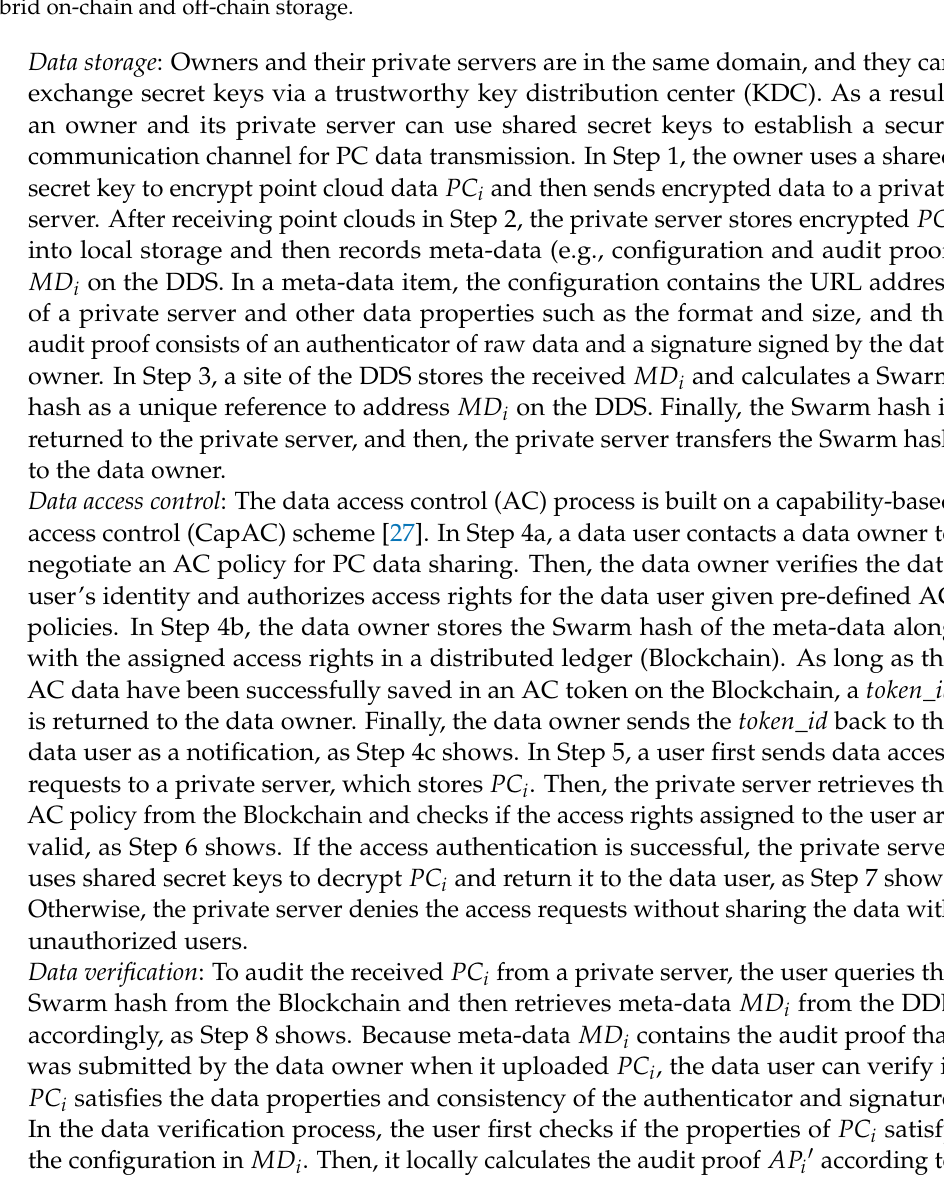
Figure 2. Illustration of Blockchain-based data authentication framework. ( a ) shows the workflow of 3D point cloud data storage, access authorization, and verification. ( b ) shows the structure of the hybrid on-chain and off-chain